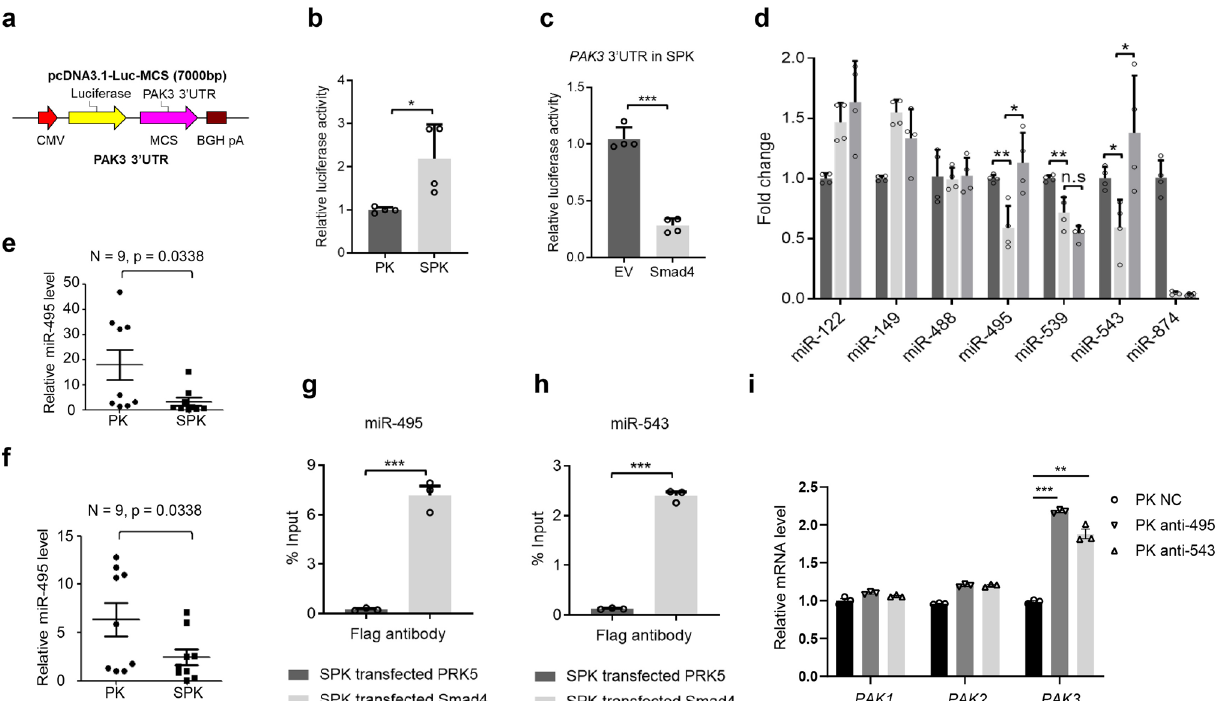
Fig. 5 Smad4 negatively regulates PAK3 via transactivation of miR-495 and miR-543 expression. a A luciferase reporter fused to PAK3 3 ′ UTRs was constructed in a pcDNA3.1-Luc-MCS plasmid. b Luciferase activities of PK and SPK cells transfected with PAK3 3 ′ UTR-Luc plasmid con fi rmed increased PAK3 expression level SPK cells. Data presented are the mean ± SD from three biologically independent samples ( n = 3); * p = 0.023816011, as determined by two-tailed Student ’ s t -test. c Luciferase reporter assay showing that overexpression of Smad4 decreased PAK3 expression level in SPK cells. Data presented are the mean ± SEM from three biologically independent samples ( n = 3); *** p = 1.58613E-05, as determined by a two-tailed Student ’ s t -test. d RT-PCR detected expression of PAK3 correlated miRNAs in PK, SPK, and SPK overexpressing Smad4 cells. Data presented are the mean ± SEM from three biologically independent samples ( n = 3); * p = 0.012761254; ** p = 0.00456168; △ p = 0.005190084; ○ p = 0.015974559; ☆ p = 0.024995116; as determined by two-tailed Student ’ s t -test. e , f Expression levels of miR-495 and miR-543 were determined in PK and SPK mouse lung tumors. n = 9, data represent means ± SEM; p < 0.05, as determined by two-tailed Student ’ s t -test. g , h The interaction between Smad4 and miR-495 ( g ) or miR-543 ( h ) in SPK cells were veri fi ed by ChIP assay. Data presented are the mean ± SEM from three biologically independent samples ( n = 3); ***( h ) p = 6.64287E-06; ***( g ) p = 0.00021899; as determined by two-tailed Student ’ s t -test. i qRT-PCR analysis gene expression in PK cells. Data presented are the mean ± SEM from three biologically independent samples ( n = 3). *** p = 5.32332E-07; ** p =